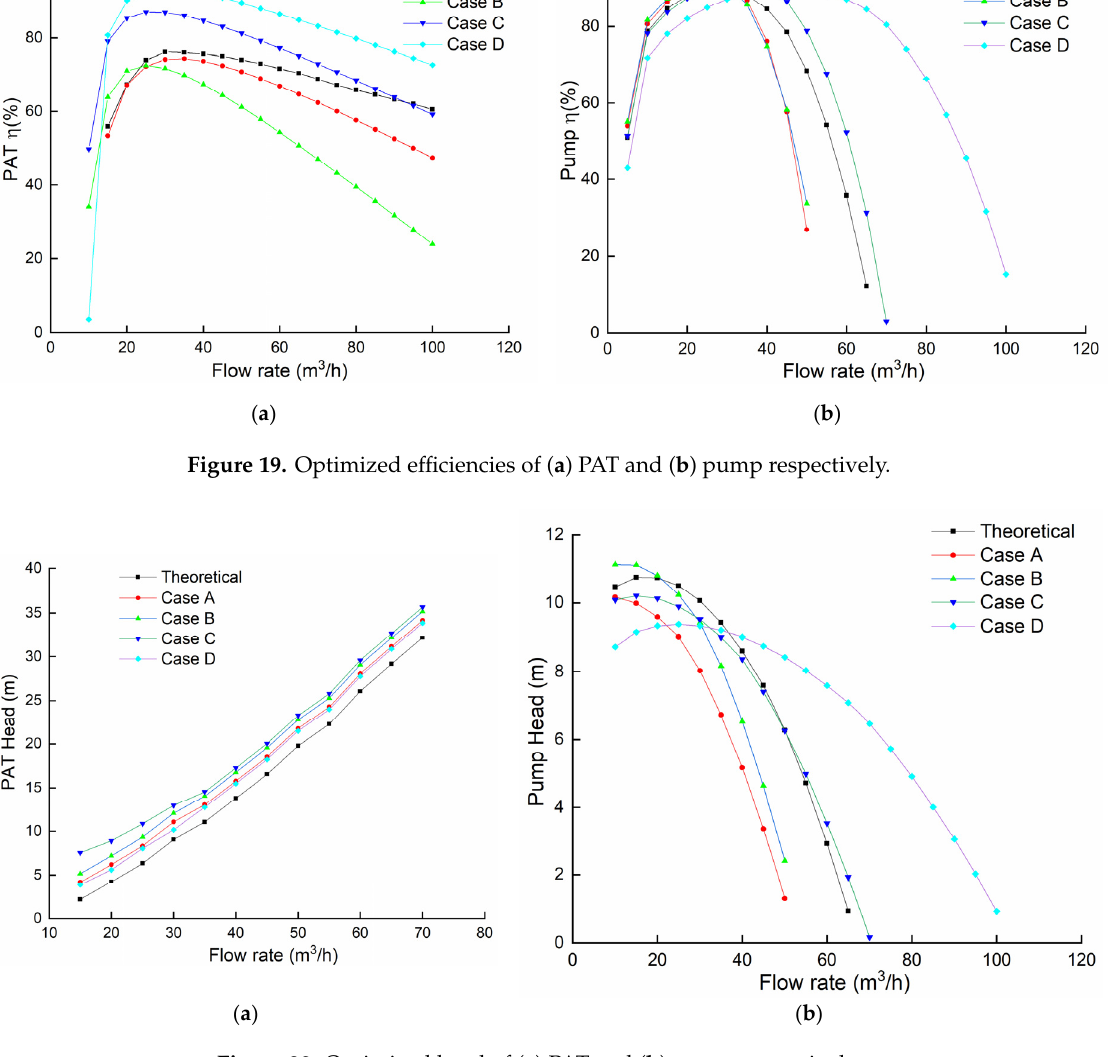
Figure 20. Optimized head of ( a ) PAT and ( b ) pump respectively.